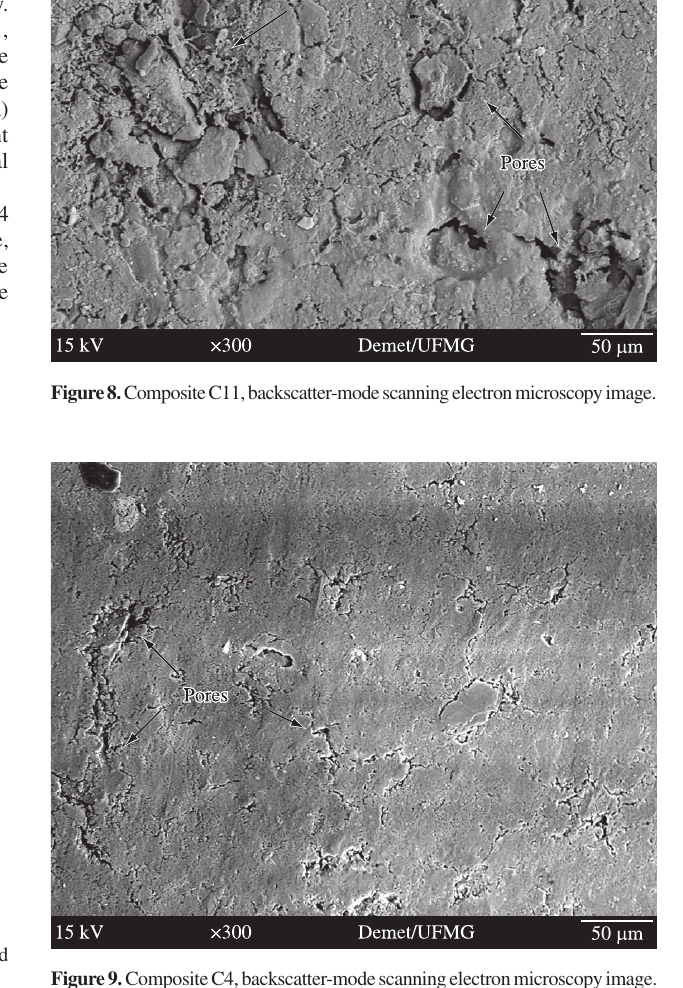
Figure 9. Composite C4, backscatter-mode scanning electron microscopy image.